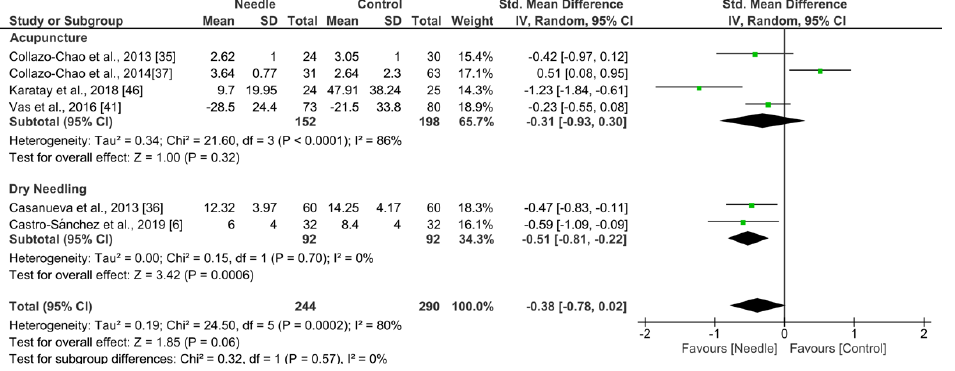
Figure 8. Forest plot for Sleeping Quality after up to 3 months.